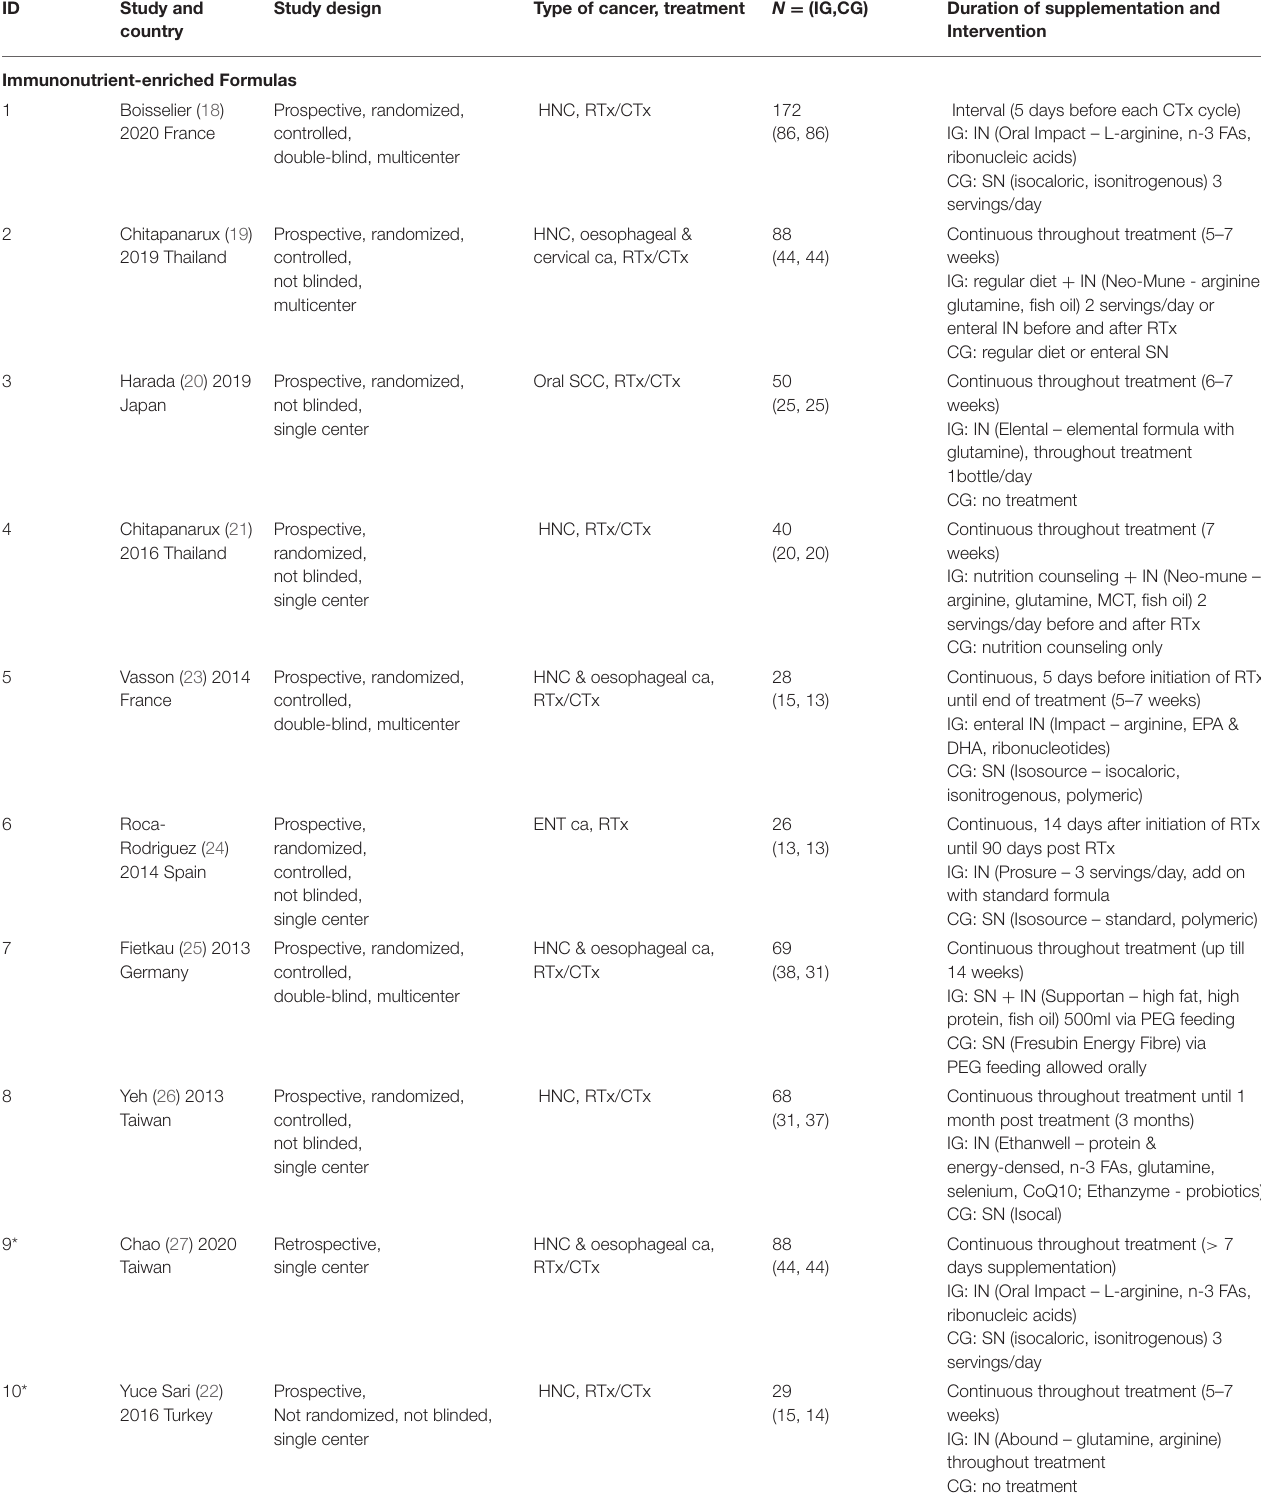
TABLE 2 | Summary of studies included in the systematic